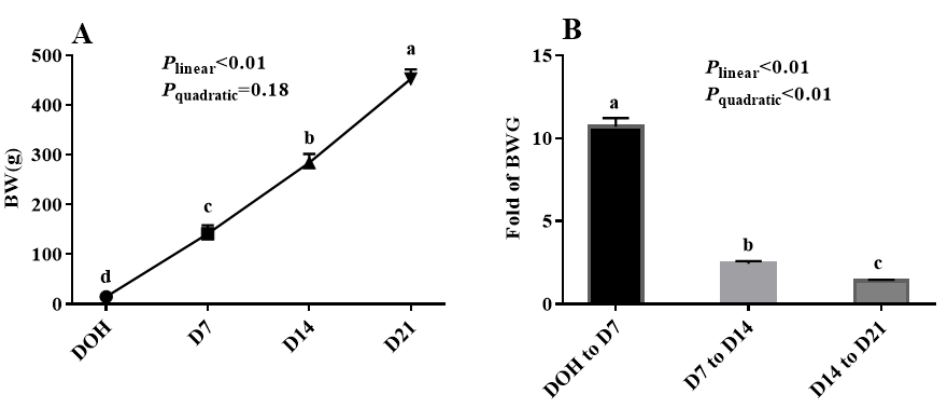
Figure 1. The age-related changes in BW and fold of BW gain (BWG) of domestic pigeon squabs. ( A ) BW, ( B ) BWG. DOH = day of hatch; D7 = day 7 post-hatch; D14 = day 14 post-hatch; D21 = day 21 post-hatch. Values are means ± SEM of 10 squabs, n=10. a–d Means within the same day sharing no common superscripts differ significantly (Tukey test, p < 0.05).